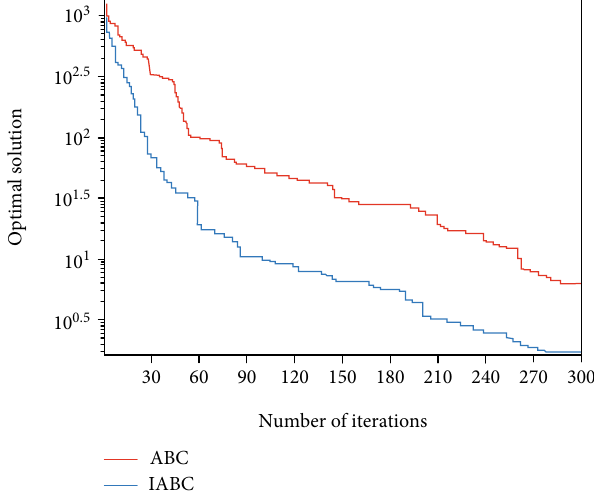
Figure 6: Test results of F7 function.